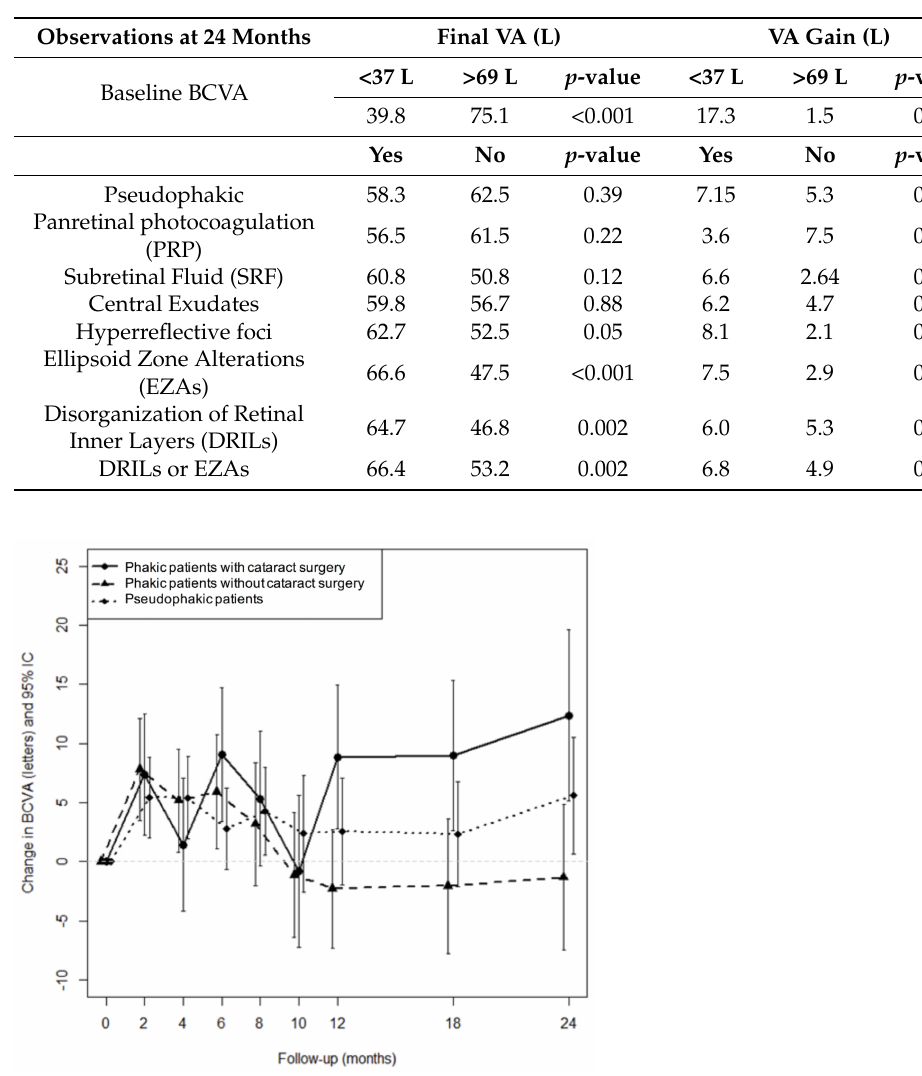
Figure 4. Treatment efficacy according to the phakic status of the